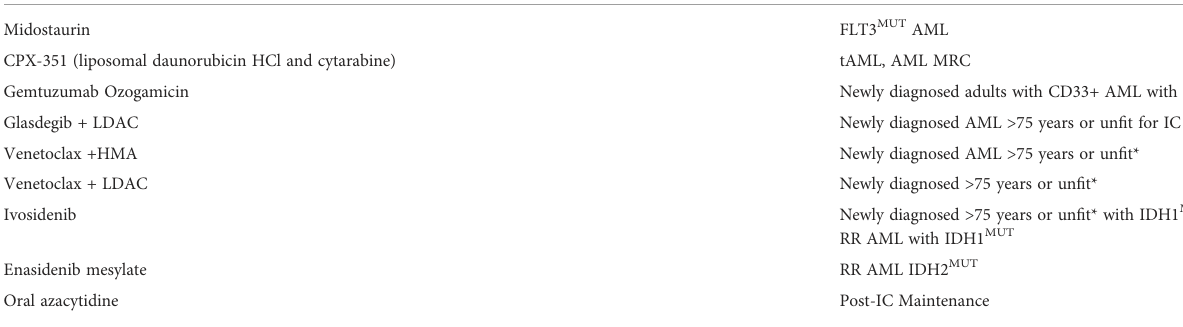
TABLE 2 Recent FDA approvals in newly diagnosed